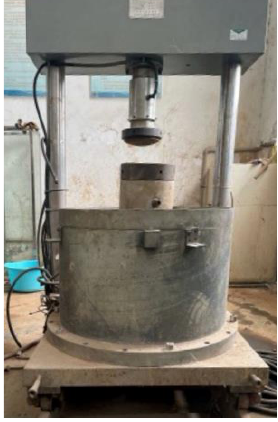
Figure 7. Large-scaled consolidator.